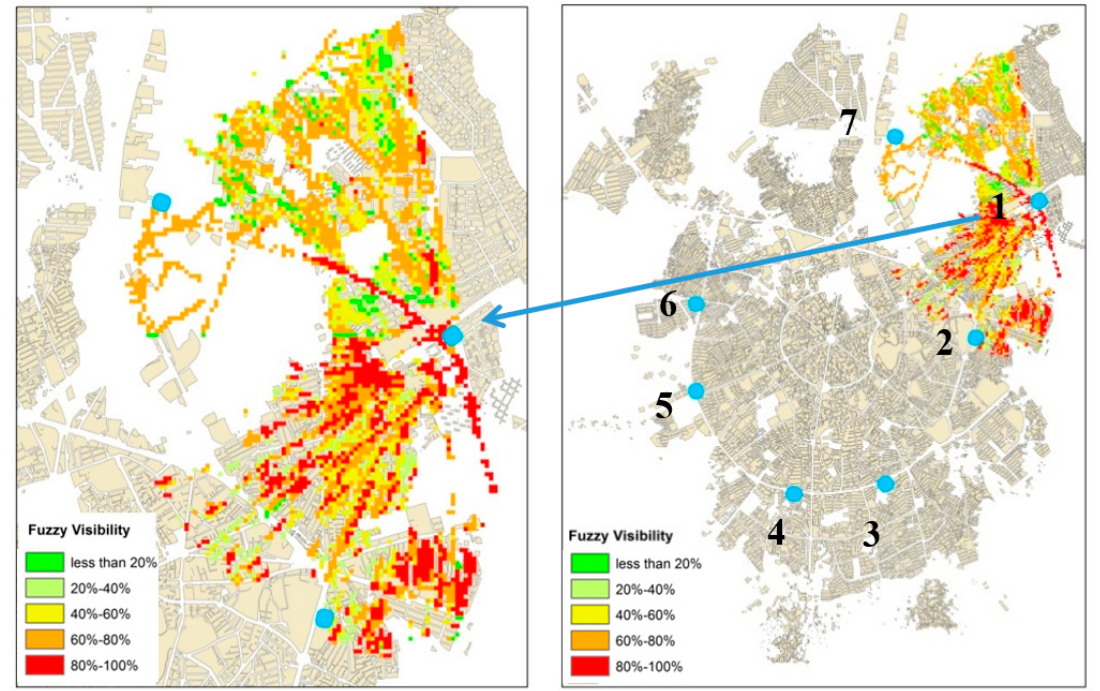
Figure 22. Visibility map of hypothetical tall building No. 1.